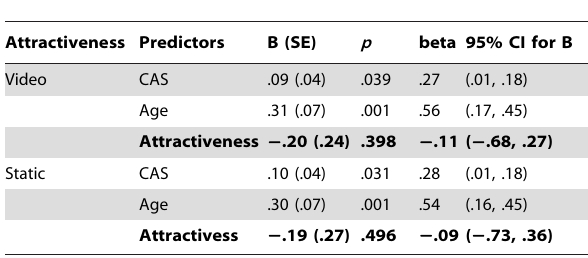
Table 4. Video-attractiveness and static-attractiveness as predictors of age at first sex, controlling sexual attitudes (CAS) and age, using multiple regression ( N